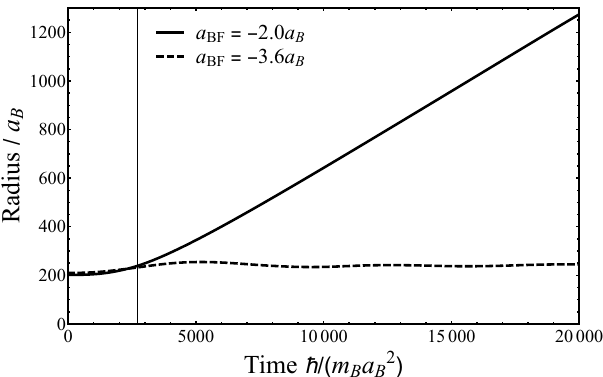
Figure 3: Width of the bosonic component of a Bose-Fermi droplet composed of = 100000 bosons and N = 10000 fermions as a function of time. The trapping N B F potential is removed in 1ms (marked by a vertical line). The solid (dashed) line / a = − 2.0 ( a / a = − 3.6). For the ratio | a corresponds to a BF B BF B which is below the critical value, both the bosonic and fermionic clouds spread out. | / a = 3.6, i.e. when the attraction is larger than the critical In the case when | a BF B one, a breathing droplet is formed. The width of the fermionic part of the droplet behaves similarly and is not